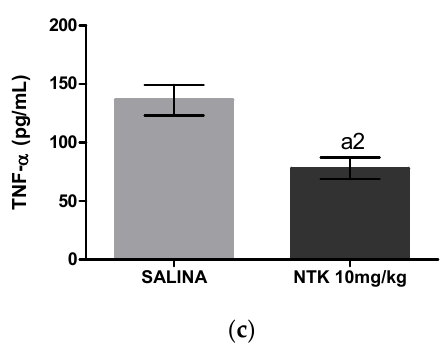
Figure 5. The effects of NTK on carrageenan-induced pleurisy. a ) The number of total leukocytes; b ) concentrations of Interleukin (IL)-1β, and c ) concentrations of Tumor Necrosis Factor (TNF)-α in the pleural lavages of mice. a4 = p < 0.0001 vs. saline and a2 = p < 0.01 vs. saline. Statistical significance was determined with one-way ANOVA and post hoc Tukey test.